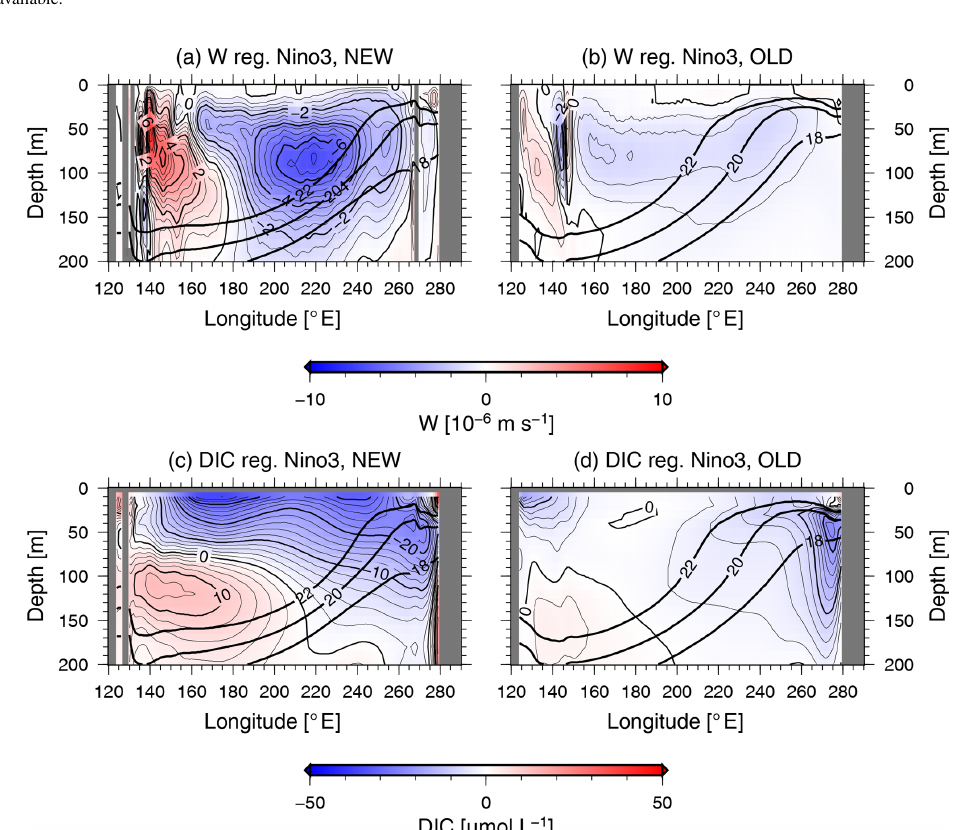
Figure 4. Anomalies of the equatorial vertical velocity (a, b) and DIC (c, d) regressed onto the standardized NINO3-SST anomalies for NEW (a, c) and OLD (b, d) . Contour intervals are 0.5 × 10 − 6 m s − 1 in panels (a) and (b) and 2 µ mol L − 1 in panels (c) and (d) . The thick solid lines indicate the climatological mean of the 18, 20, and 22 ◦ C isotherms.